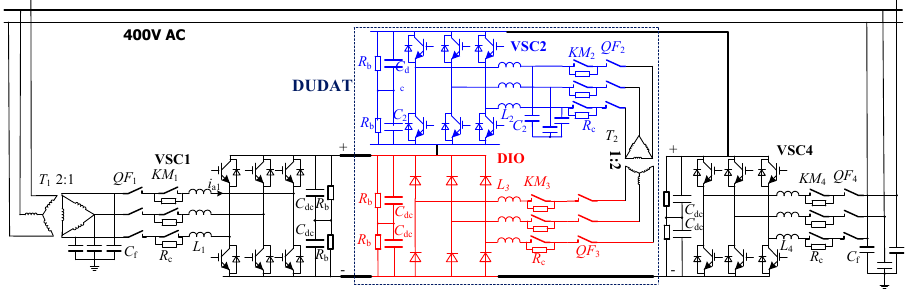
Figure 11. Schematic of the experimental set-up of DUDAT. Table 6. Parameters of passive components of the test rig.